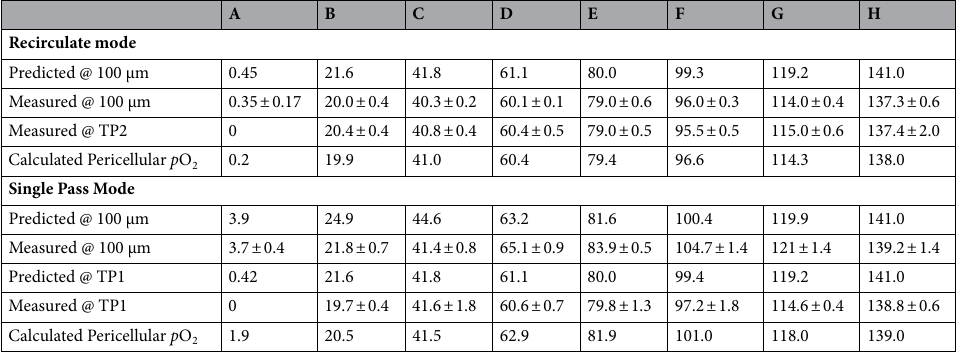
Table 1. Predicted, measured and calculated p O 2 Levels at 37